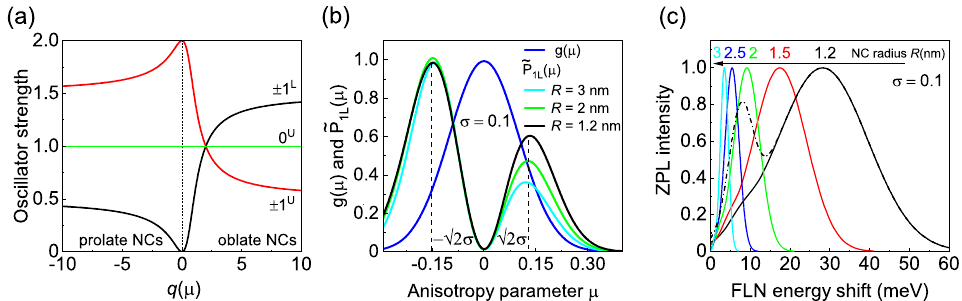
Figure 5. ( a ) Relative oscillator strengths of the ± 1 L , ± 1 U and 0 U excitons depending on the parameter q ( µ ) . ( b ) Anisotropy distribution g ( µ ) and weighted oscillator strength ˜ P 1 L in zb-CdSe NCs with different radii for σ = 0.1. ( c ) Shape of the zero phonon line in NCs of different sizes. The black dash-dotted line is calculated assuming equal emission efficiencies of the ± 2 and 0 L states. Solid lines are calculated assuming that the emission efficiency from the 0 L is an order of magnitude smaller than that from the ± 2